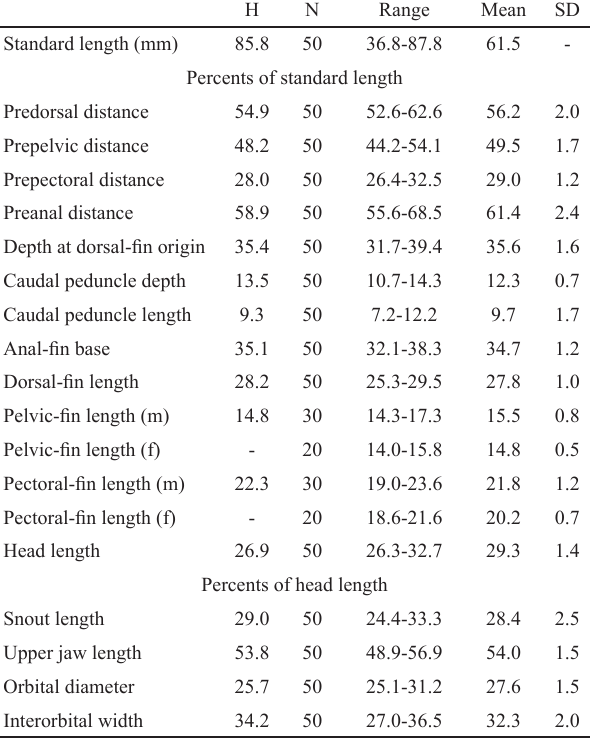
Color in alcohol. Ground color dark yellow in dorsal region of body and head, gradually lighter on sides. Dark brown longitudinal lines usually forming a zigzag pattern between longitudinal rows of scales, except immediately above anal-fin base; more conspicuous along the longitudinal axis of the body, more visible in specimens larger than 50.0 mm SL (Fig. 1). Small black chromatophores scattered over rays of all fins. Adipose fin without distinctive marks, except for the anterodorsal border smoothly light gray pigmented. Small black spot vertically expanded at base of median caudal-fin rays (Figs. 1-2). Specimens measuring 42.0-50.0 mm SL with one or two faint and vertically elongate humeral spots. Color pattern of specimens smaller than 41.0 mm SL similar to that of large specimens, but always with two black vertically elongate humeral spots; anterior